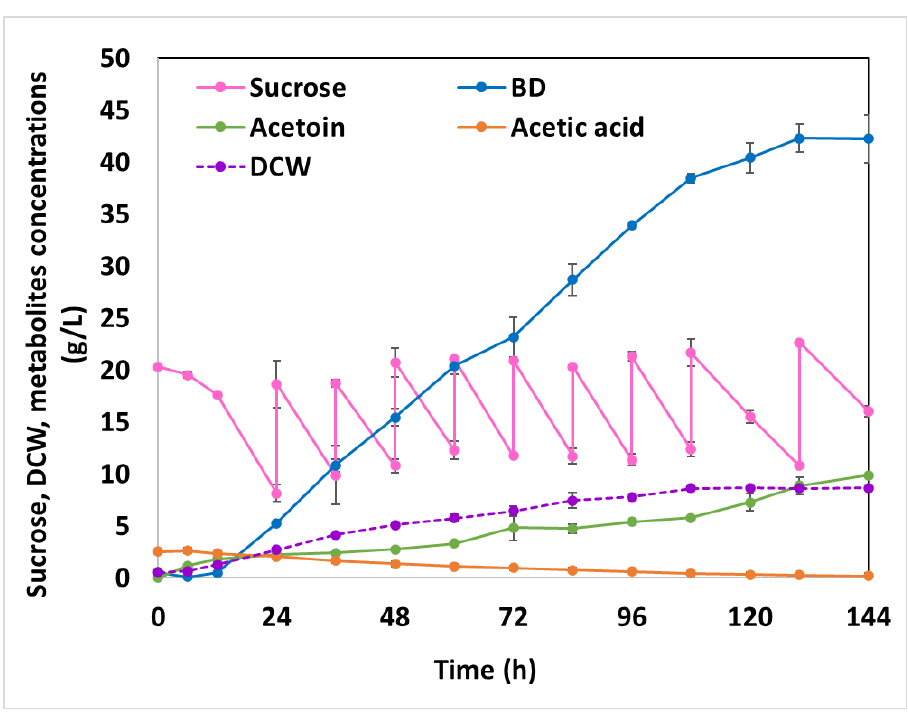
Figure 6. Fed-batch fermentation by B. subtilis in MMRS medium in 2 L benchtop bioreactor with uncontrolled %DO and a constant residual sugar feeding method, at 30 ℃ , pH 6.0, agitation speed 180 rpm, aeration 1.0 vvm.